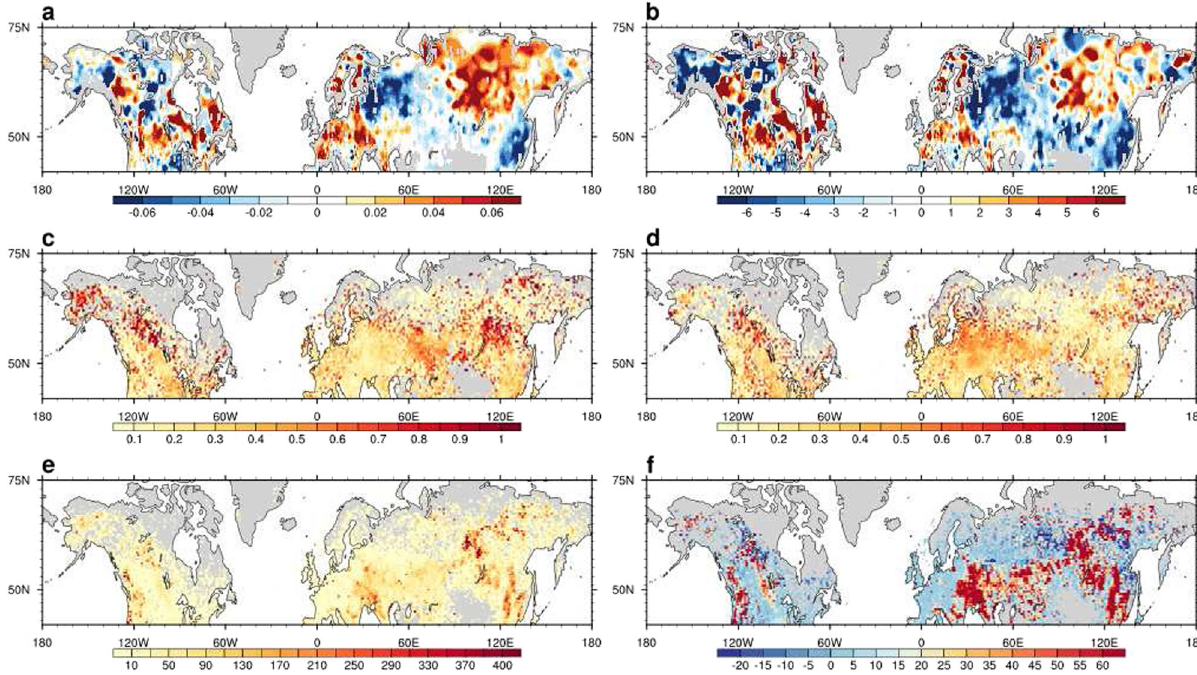
Fig. 7 Temporal changes of fi res, PFIv2 and DD. Differences between PFIv2 averaged in 2015 – 2020 and 2001 – 2016 intervals ( a ). b shows the same as ( a ) but for differences in the period of drought (DD). c and d shows ratio between 2015 and 2020 accumulated fi res during AO + and PNA + and the total number of fi res in the period. e Total accumulated fi res from 2015 to 2020. f shows differences between averaged annual fi res between 2015 – 2020 and 2001 –